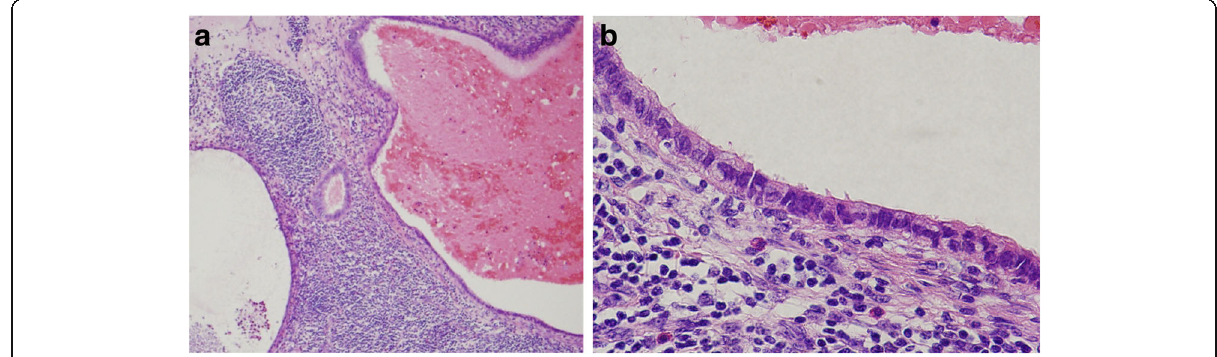
Fig. 5 a Endometrial glands were present in lymph nodes around the ileocolic artery, and there were only small changes in the gland structure (H&E, low magnification). b Luminal structures accompanied by pilus structures were present in the lymph nodes around the ileocolic artery (H&E, high